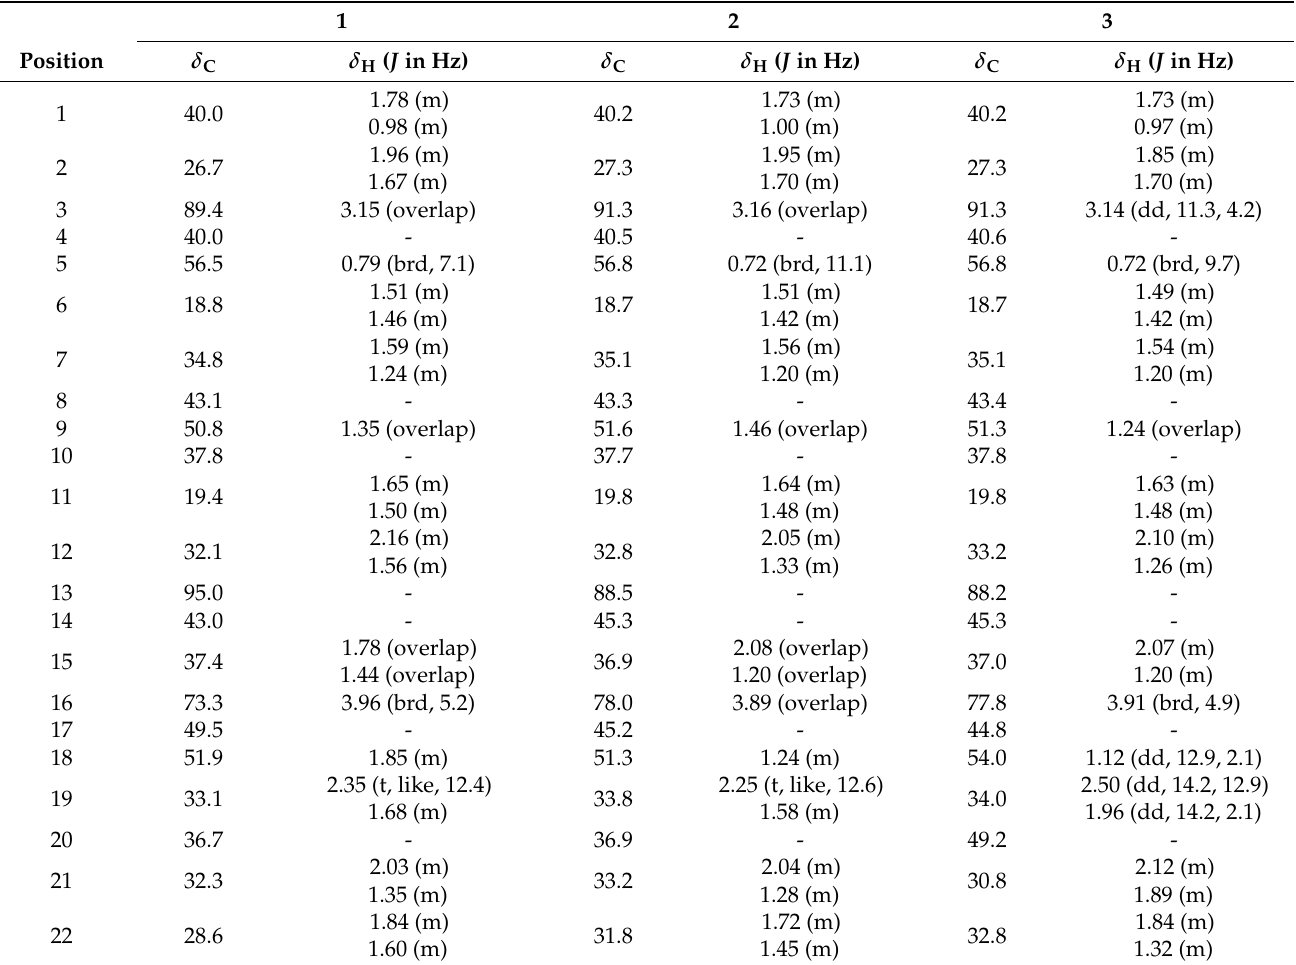
Table 1. 1 H and 13 C-NMR data of compounds 1–3 in methanol- d 4 ( δ in